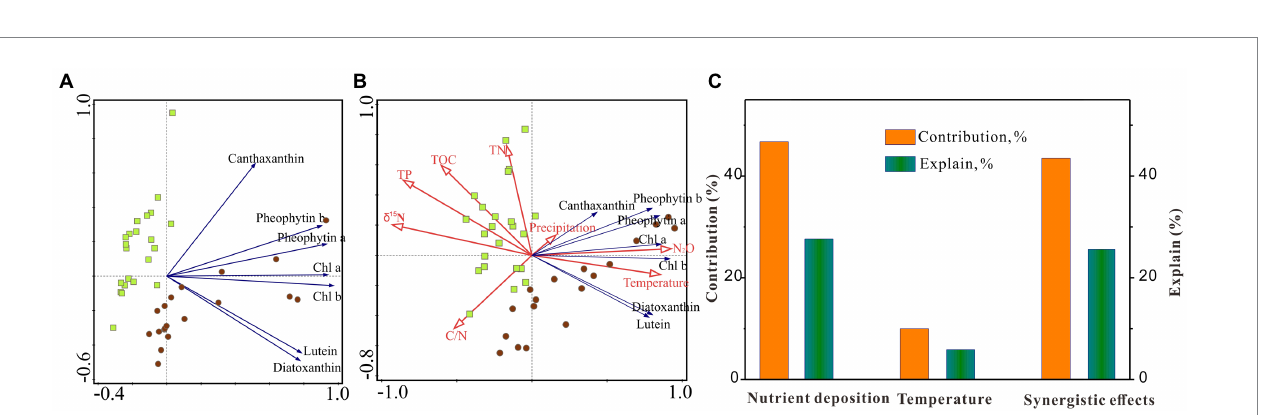
FIGURE 4 (A) Principal components analysis of pigments and (B) redundancy analysis between pigments and significant explanatory variables including temperature, precipitation, δ 15 N, N 2 O emission, TOC, TN, C/N, and TP. (C) Variation partitioning analyses was further performed to investigate the synergistic effects of two main forcing factors (climate warming and atmospheric nutrient deposition) on algal community